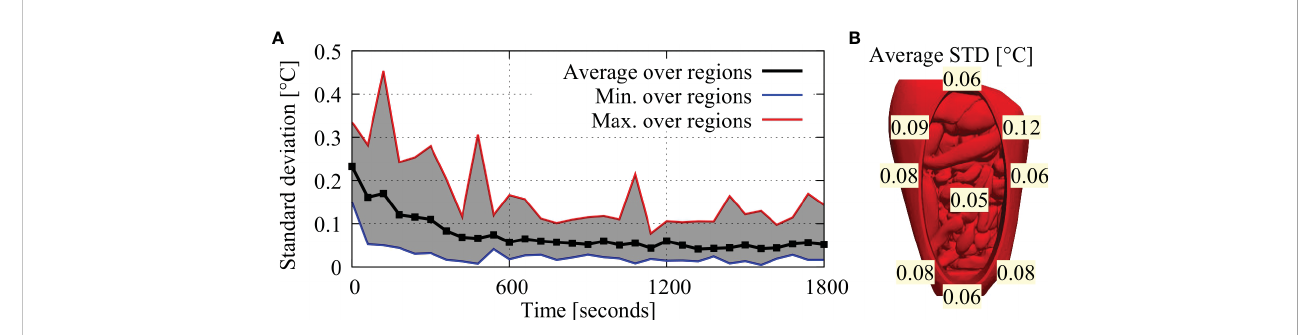
FIGURE 4 (A) Minimum, maximum and average standard deviations over all regions, plotted over time. Standard deviations are highest near the start of the experiment and decrease towards a steady-state near the end of the experiment. (B) Average standard deviations per